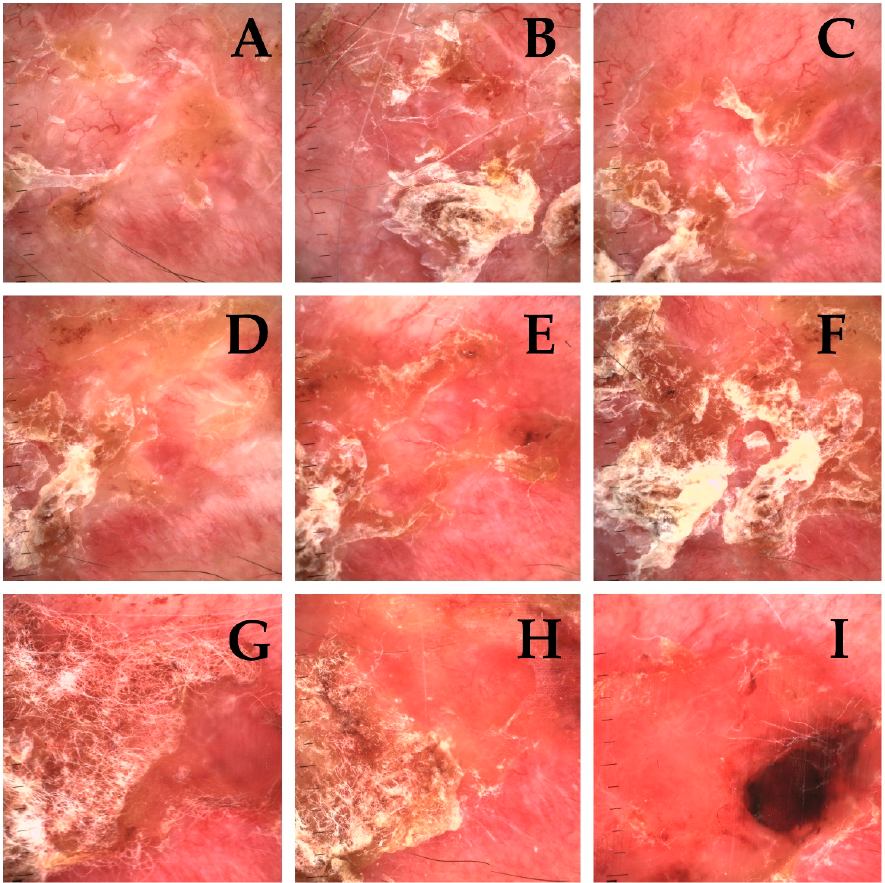
Figure 5. Dermoscopic presentation of basal cell carcinoma, nodular (adenoid type), localized on the forehead of 76-year-old patient. ( A )—Dermoscopic image before brachytherapy showed the presence of—polymorphous, branched, linear and serpentine vessels, as well as white, shiny clods, perpendicular white lines and white and polychromatic structureless zones, white scale. ( B – H )—Dermoscopy of the BCC during subsequent treatment fractions (t2–t8) revealed diminishing number of serpentine, branched vessels as well as formation of the ulceration arising (t9) ( I